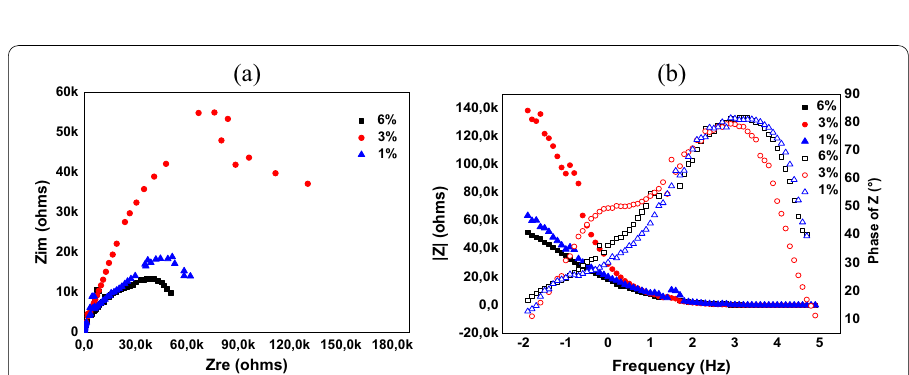
Fig. 10 The impedance curve of the molybdate and the different phosphoric acid concentrations according to the representation of a Nyquist plots and b Bode plots in 3.5%